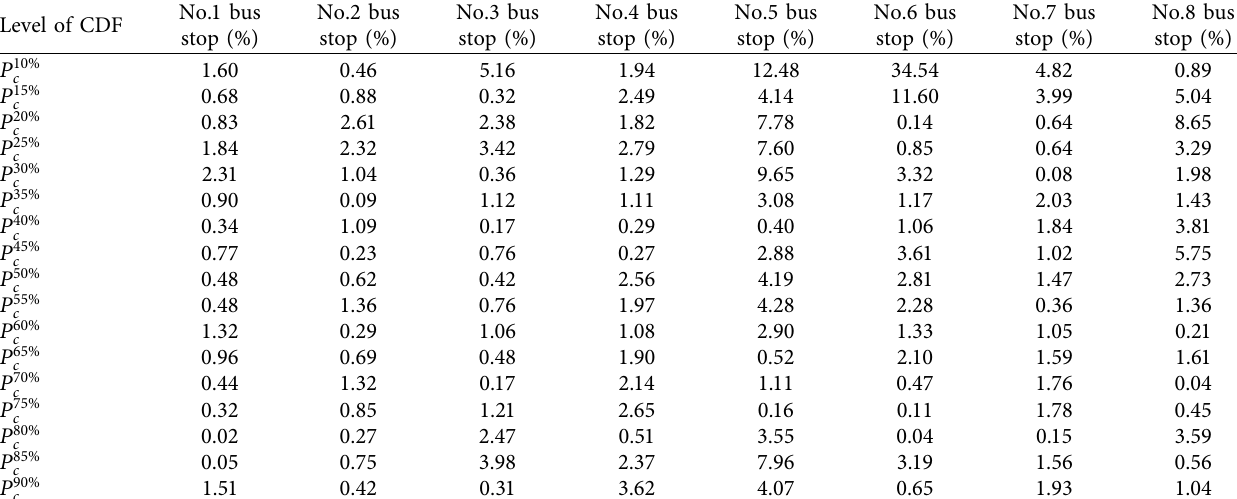
Table 8: Relative error between actual and fitted FDR for test bus stops at different CDF levels. No.1 bus Level of CDF